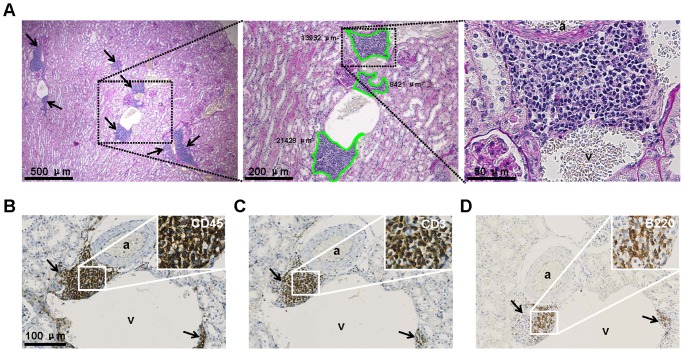
Phenotypic characterization of perivascular immune cell clusters in the aged mouse kidney.(A) PAS staining was used for computerized morphometric analysis. Left panel: low-power magnification (40x) showing representative perivascular infiltrates (arrows) in a male C57L/J mouse. Middle panel: higher-power magnification (100x) of the left panel showing three individually measured perivascular cell clusters. The cell clusters were encircled and the surface area was calculated and expressed in μm2 as indicated. Right panel: high-power magnification (400×) of the middle panel. (B) The immune cell clusters consisted of CD45+ cells of which the majority was CD3+ T cells (C) and B220+ B cells (D). Panels B, C & D display serial sections (magnification: 200×). Insets show high-power magnifications (500x) of the indicated areas. Arrows indicate immune cell clusters. a: arteriole, v: vein.